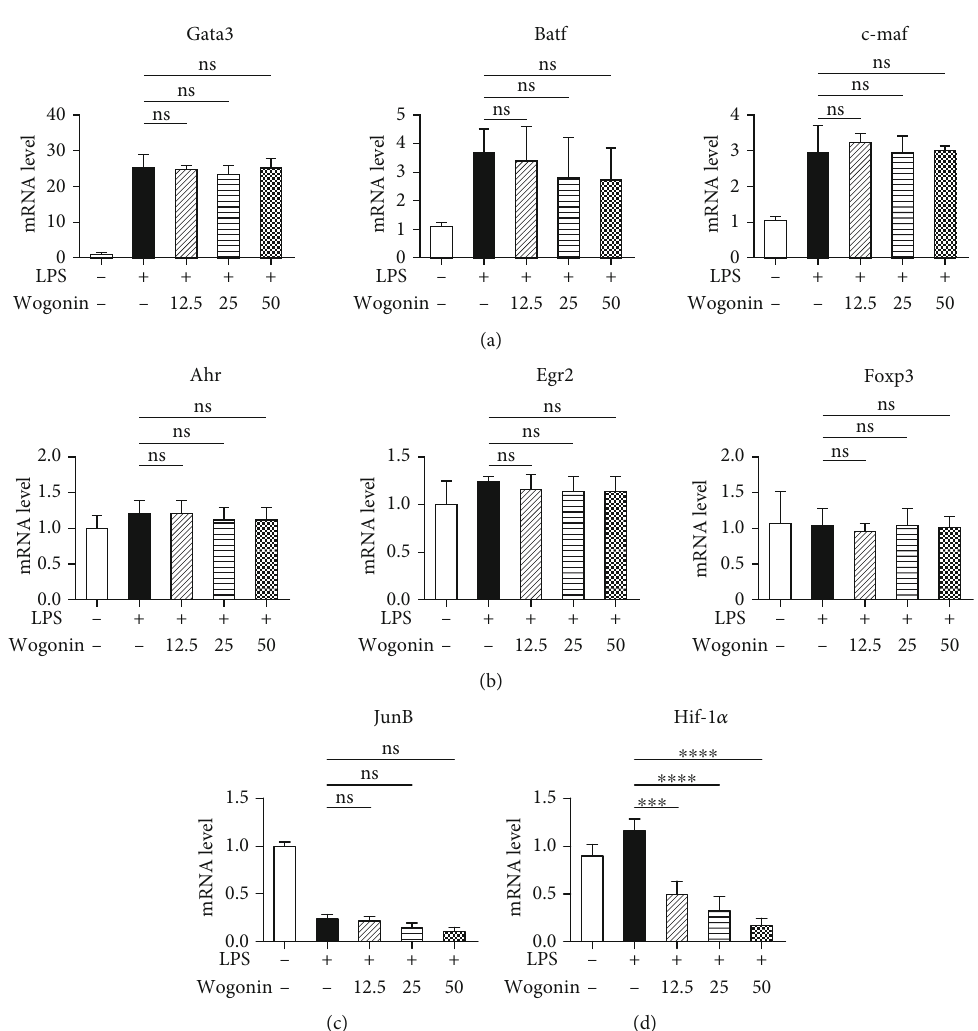
Figure 6: E ff ect of Wogonin on the relative transcription factor levels of IL-10 in B cells. B cells were cultured with or without LPS in the presence of Wogonin (0, 12.5, 25, and 50 μ M) for 6h. Total RNA was extracted by Trizol and then reverse-transcribed. (a – d) The mRNA levels of Gata3, Batf, c-maf, Ahr, Egr2, Foxp3, JunB, and Hif-1 α were measured by RT-PCR. The results are representative of three repeated experiments. ∗∗∗ P < 0 : 001 ; ∗∗∗∗ P < 0 : 0001 ; ns: no signi fi